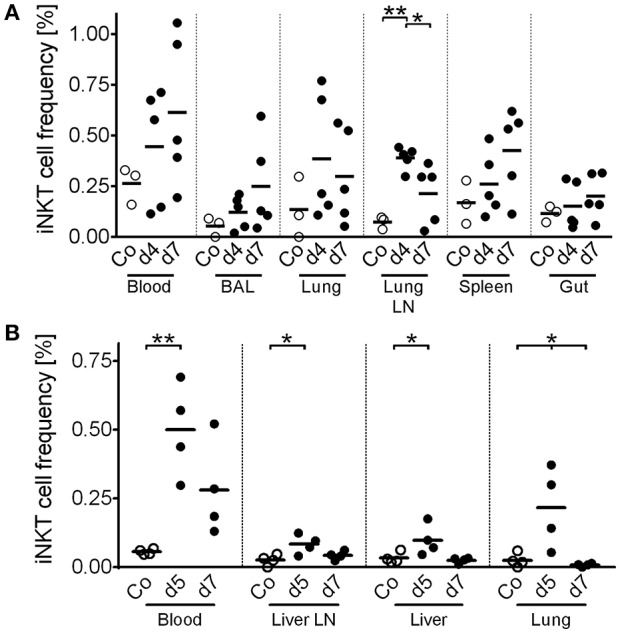
In vivo dynamics of porcine iNKT cells during viral infections. Pigs were experimentally infected with (A) IAV (n = 3-5) or (B) ASFV (n = 4). At the indicated time after infection, animals were euthanized and lymphocytes of the indicated tissues were isolated. Frequency of iNKT among CD3+ lymphocytes was then investigated using flow cytometry. Open circles show uninfected control animals (Co). Closed circles show infected animals at the indicated time post infection. Each symbol represents an individual animal with a line indicating mean. BAL, Broncho alveolar lavage. Lung LN, lung lymph node (Nodi lymphatici tracheobronchales inferiores). Liver LN, liver lymph node (Nodi lymphatici hepatici). *p < 0.05, **p < 0.01, ordinary one-way ANOVA with Holm-Sidak's post-hoc test for multiple comparisons.